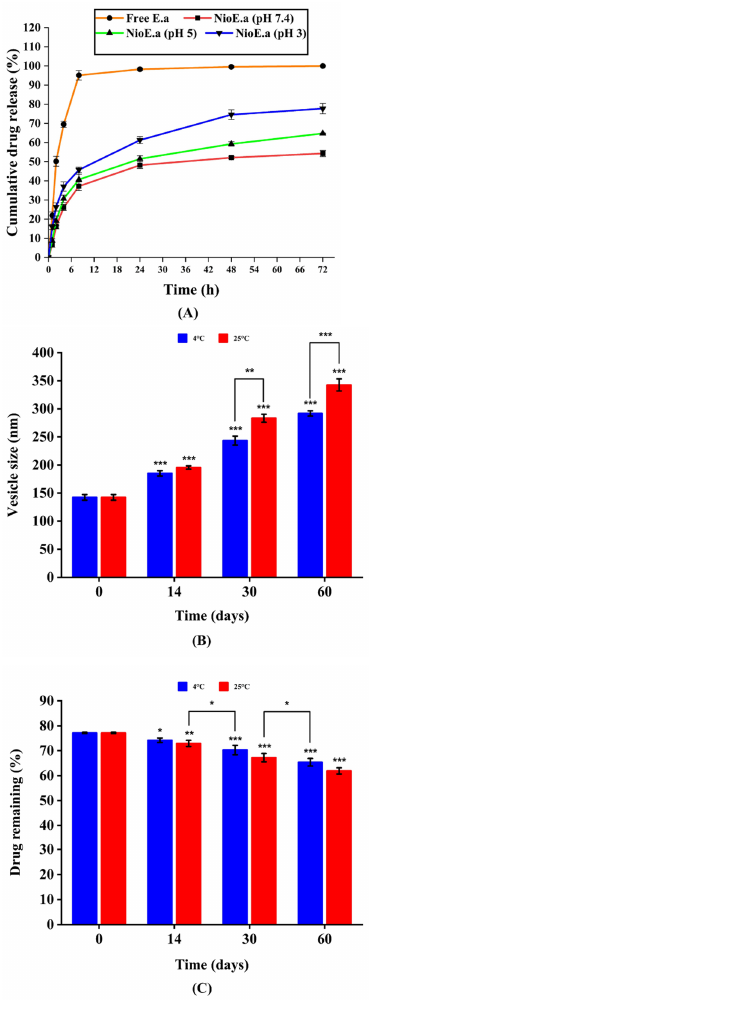
Commented [M5]: Author want to Add. And fingur 3 picture has been changed.